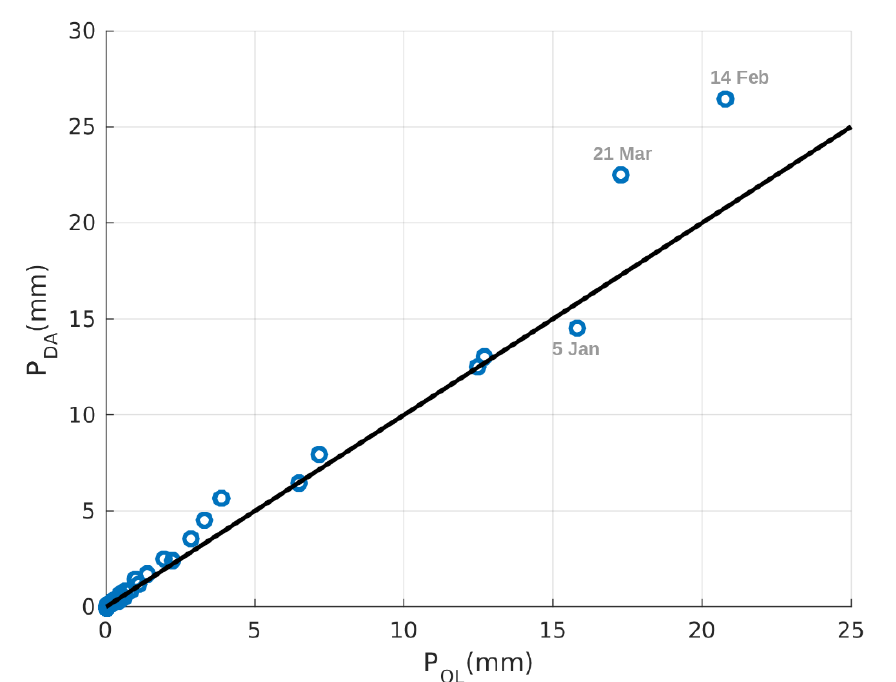
Figure 12. Comparison between the open loop and data assimilation mean daily precipitation over the Rheraya